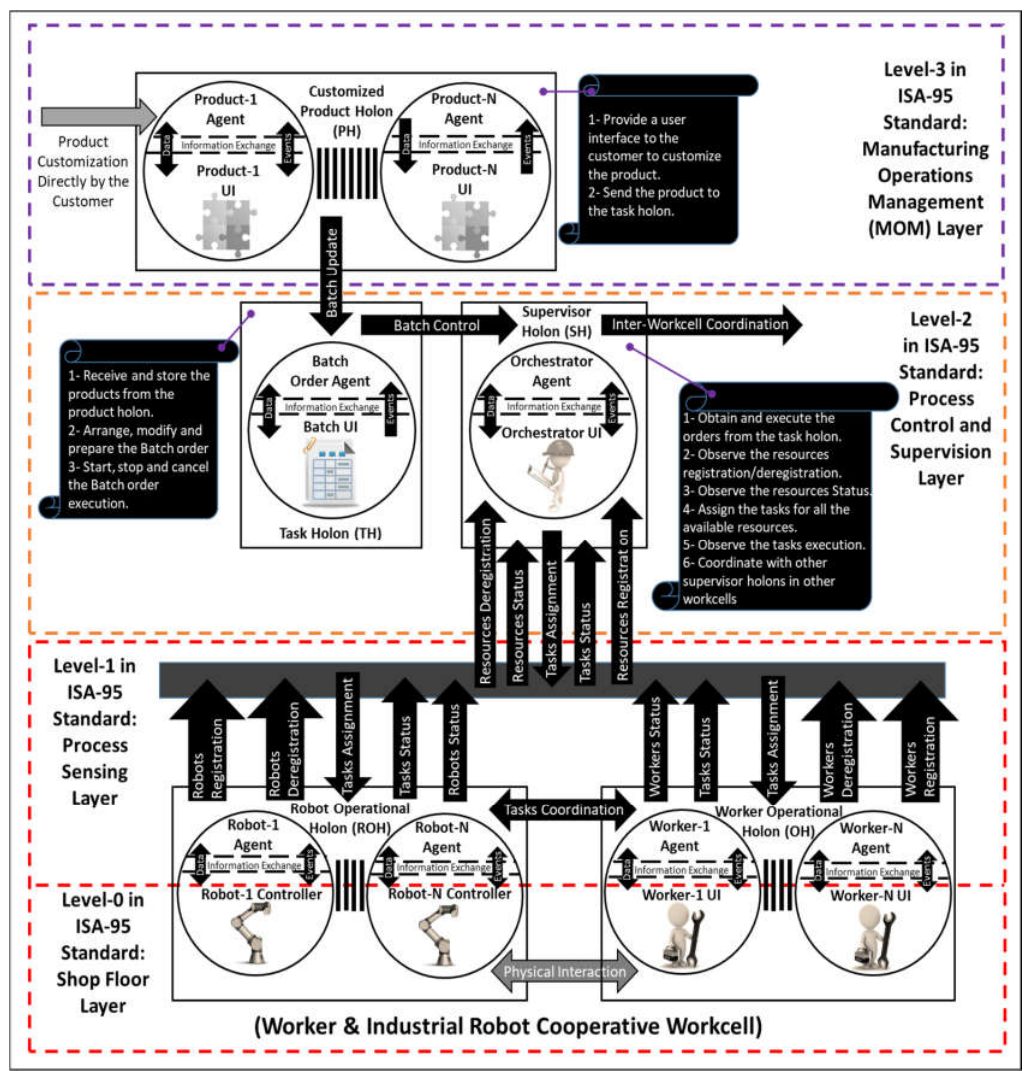
Figure 4. Combined ADACOR and ISA-95 Conceptual Model.